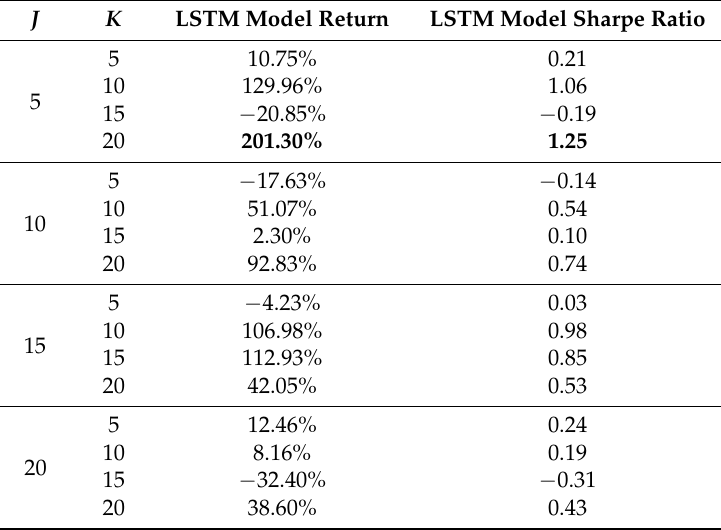
Table 9. Performance of the LSTM